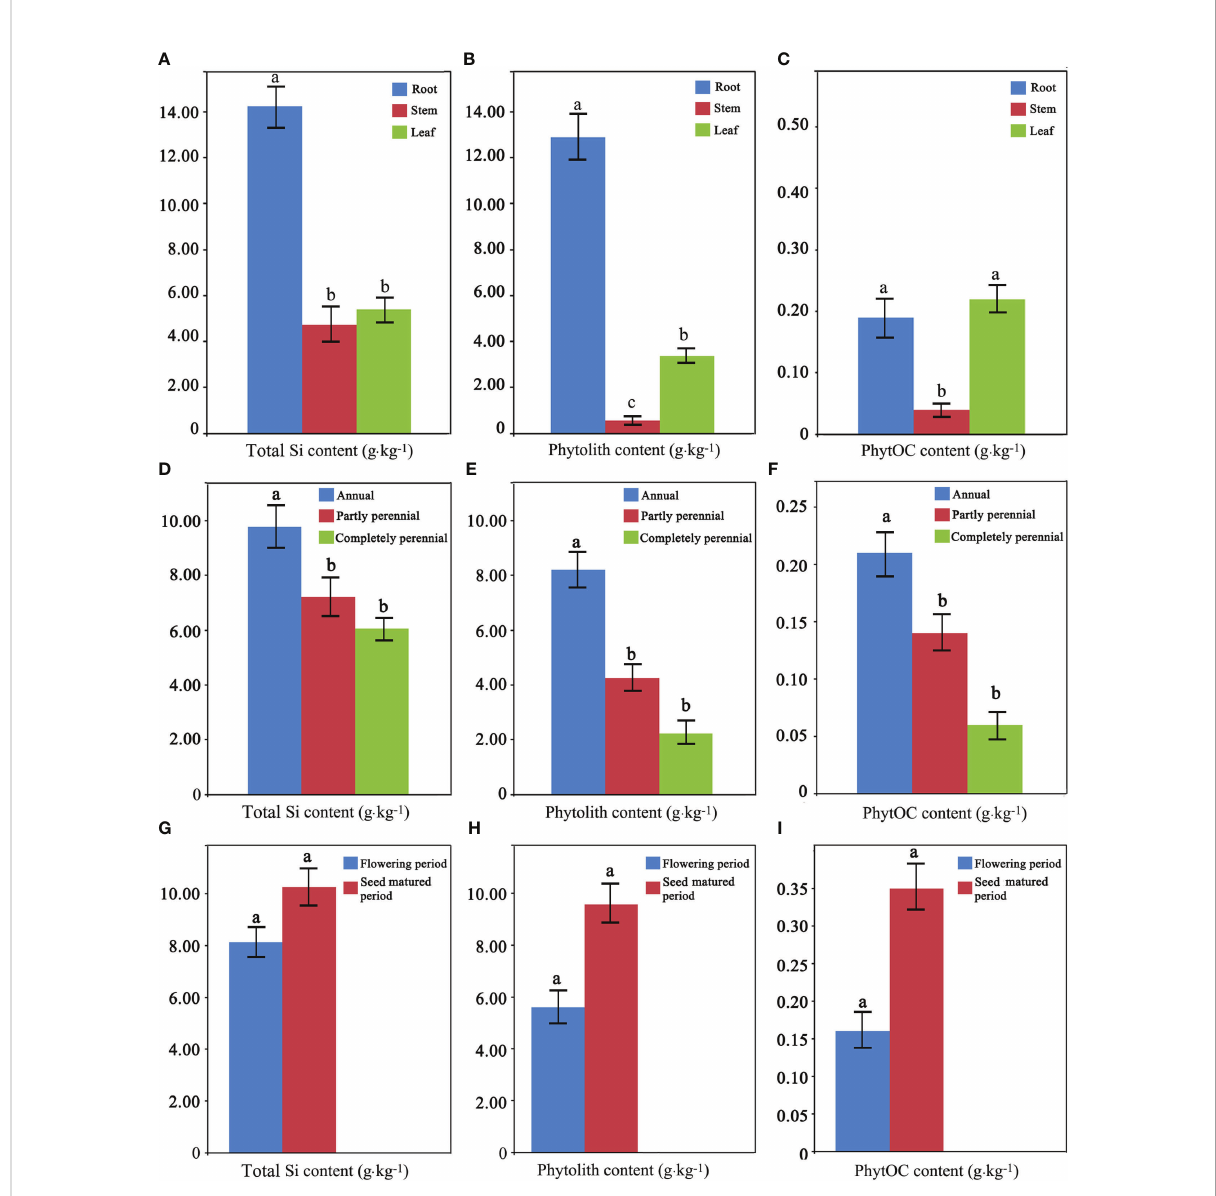
FIGURE 3 Total silicon (Si) (A, D , G) , phytolith (B, E , H) , and phytolith-occluded organic carbon (PhytOC) (C, F , I) content between different organs (A – C) , different periods (D – F) , and different live forms (G – I) of Fagopyrum